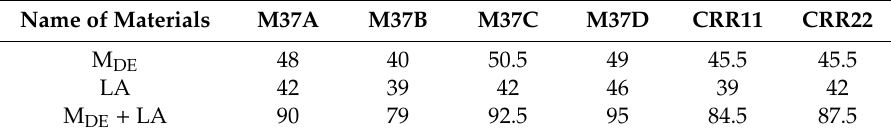
Table 8. Micro-Deval resistance and LA abrasion resistance of di ff erent samples